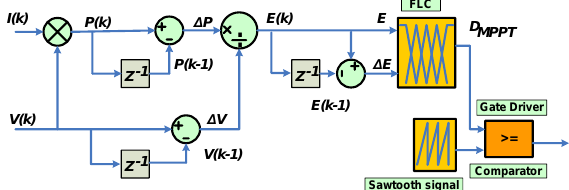
Figure 3. Circu it Schematic diagram of the AFL− MPPT method. Figure 3. Circuit Schematic diagram of the AFL − MPPT method. Table 1. Fuzzy rule base.